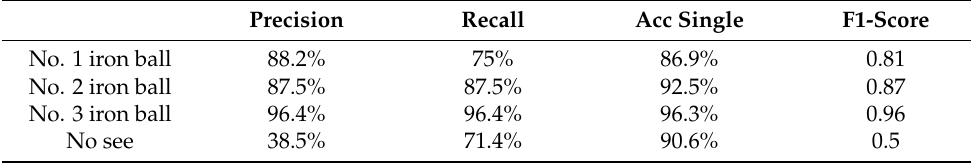
Table 6. Model reference index